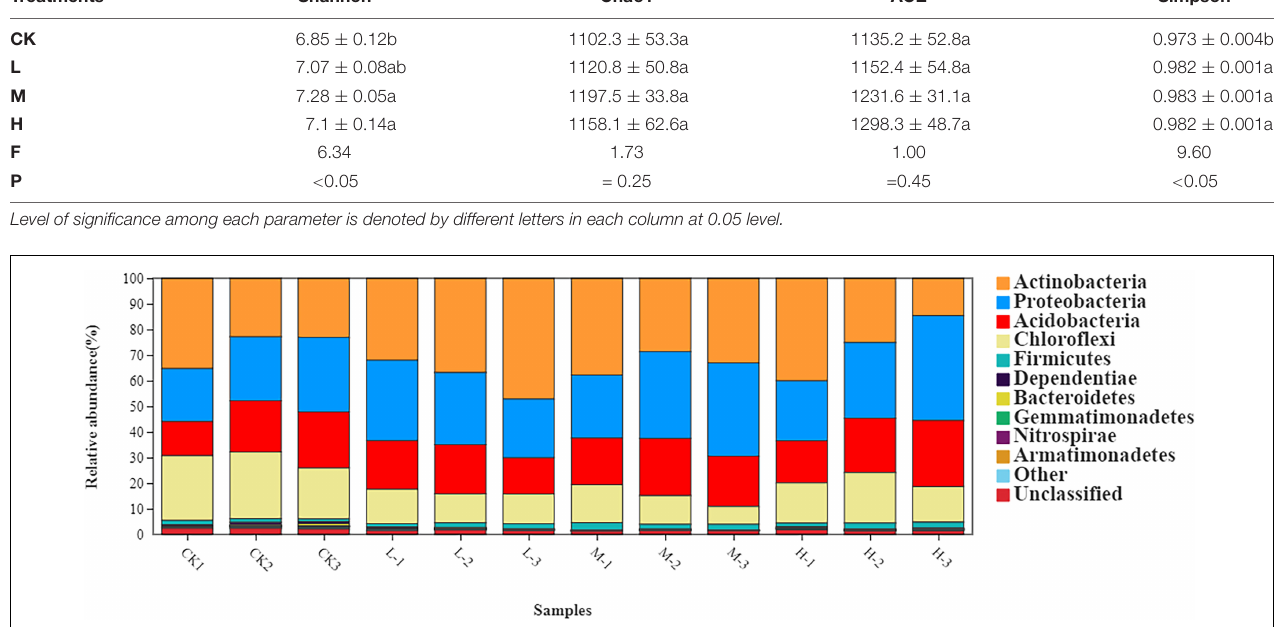
TABLE 2 | Sugarcane rhizosphere alpha diversity under different nitrogen application. Treatments